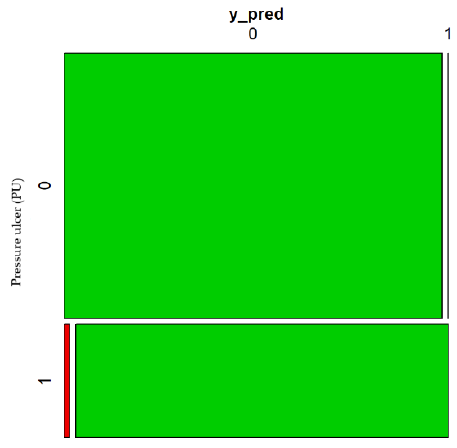
Figure 4. Confusion matrix 1 of the estimated model.